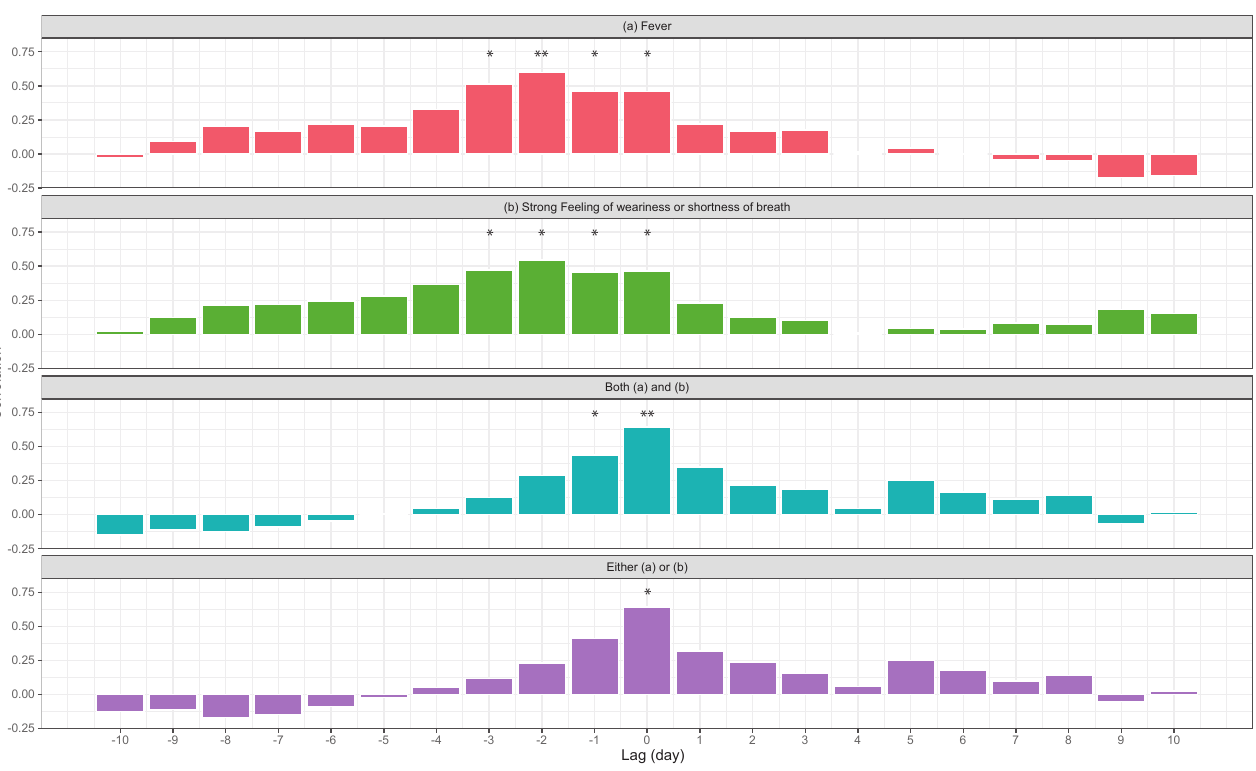
Figure 4. Cross correlation function between the time series of reported number of COVID-19 cases and the shifted time series of the proportion of non-speci fi c symptoms (shifted days between % 10 to 10). ** P < 0.01, * P <